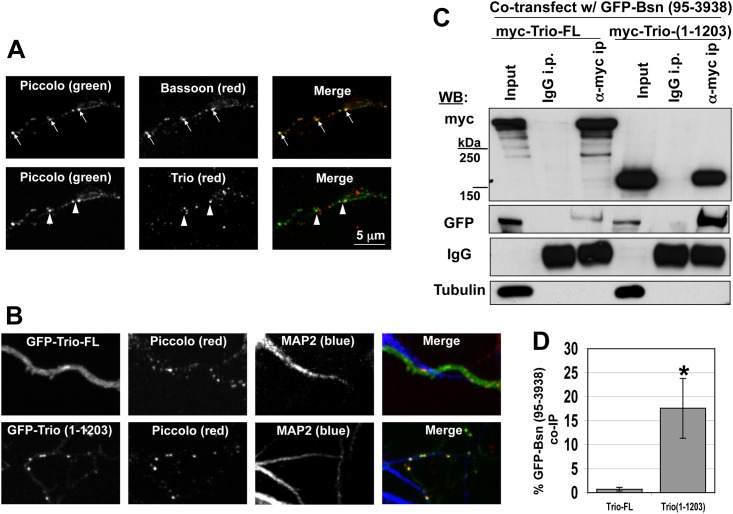
The C-terminus of Trio inhibits binding with Piccolo/Bassoon on PTVs.(A) Images of axons from immature neurons (5DIV) immunostained with Piccolo, Bassoon, and Trio. In these neurons, Piccolo and Bassoon co-localized (arrows in top panel), while Piccolo and Trio did not (arrowheads in bottom panel). (B) Axons from neurons (5DIV) expressing GFP-Trio-FL or GFP-Trio (1–1203), stained for Piccolo and MAP2. In these immature axons, GFP-Trio-FL remained diffuse, while GFP-Trio (1–1203) was punctate and colocalized with Piccolo. (C) Western blot of co-immunoprecipitation (IP) experiments comparing the ability of Myc-Trio-FL and Myc-Trio (1–1203) to co-IP with GFP-tagged Bassoon [GFP-Bsn(95–3938)]. Tubulin was included as an additional control demonstrating a lack of non-specific co-IP. (D) Quantification of panel C, obtained by dividing the pixel intensity of the GFP-Bassoon band in the anti-Myc lane by the GFP-Bsn band in the input lane and normalizing the results to the total amount of GFP-Bsn present in the lysate. Trio1-1203 immunoprecipitated Bassoon more effectively than full-length (FL) Trio. * = p < 0.05. n = 5.